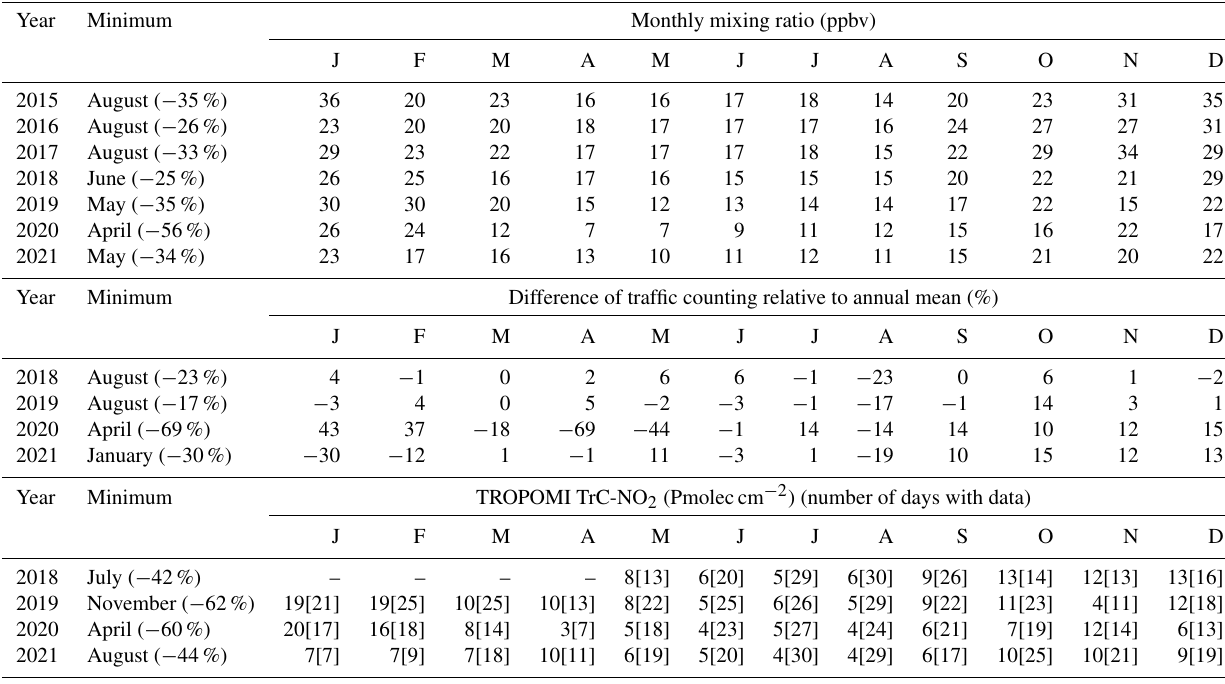
Table F1. Monthly mean surface NO 2 mixing ratios over 2015–2021, on average over individual monitoring stations located within around 10km from the city center of Madrid (here including both traffic and urban background stations) and the month of minimum NO 2 levels (with relative difference against the annual mean into parentheses). Below, we provide the relative differences (against annual mean) of traffic counting in the Madrid region available over 2018–2021. In the bottom, monthly mean TROPOMI TrC-NO 2 in Madrid are also given (with the number of days with available data into